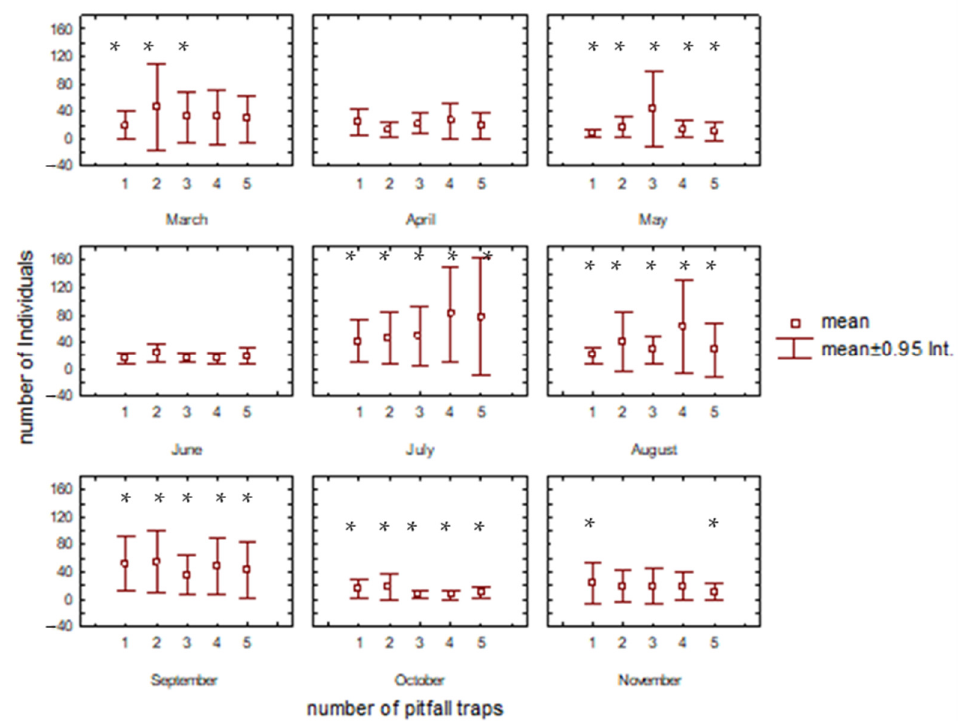
Figure 6. Mean numbers of individuals (±95% CI) in pitfall traps located in the ecotones (traps 1 and 2) and in the fields (traps 3, 4, 5). Significant impact (*).